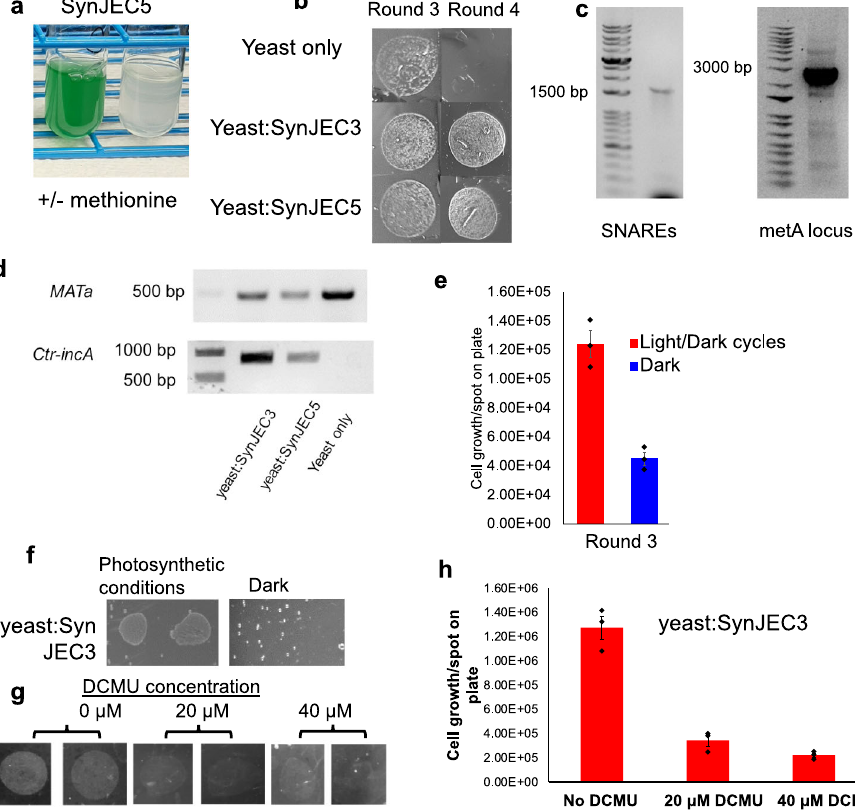
Fig. 5 Rescue of respiration-de fi cient phenotype by yeast- SynJEC chimeras containing auxotrophic SynJEC5 cells. a Growth of SynJEC5 cells in BG-11 medium in the presence and absence of L-methionine b Growth of yeast- SynJEC3 and yeast- SynJEC5 chimeras on Selection Medium III. The experiment was repeated three times independently with similar results. c Total DNA analysis of SynJEC5 DNA reveals the presence of genomic SNARE-like proteins Ctr-incA and CT813 (left) and disruption of the metA gene with a kanamycin resistance marker (right). The experiment was repeated twice independently with similar results. d Total DNA of yeast-SynJEC chimeras contains yeast MATa and SynJEC Ctr-incA genes. The experiment was repeated three times independently with similar results. e S. cerevisiae cox2-60 -SynJEC3 chimeras are generated under and selected under photosynthetic conditions. After two rounds of growth S. cerevisiae cox2-60 -SynJEC3 chimeras are propagated either under standard photosynthetic conditions or under dark; initial number of cells plated per spot is 10 4 ( N = 3 technical replicates; data are presented as mean values + / − SEM). P -values were calculated by two-tailed t -test comparing the two means (95% CI, Cohen ’ s d = 6.2, P = 0.0016). f SynJEC3 are starved for light for 72 h and the fused to S. cerevisiae cox2-60 and selected under dark conditions (dark fusions). The S. cerevisiae cox2-60- SynJEC3 chimeras generated from dark fusions fail to grow whereas the control S. cerevisiae cox2-60- SynJEC3 chimeras propagated under photosynthetic conditions propagate as previously observed. The experiment was repeated twice independently with similar results. g Plate images to demonstrate the effect of (3-(3,4-dichlorophenyl) − 1,1-dimethylurea), DCMU, on S. cerevisiae cox2-60- SynJEC3 chimeras. The experiment was repeated twice independently with similar results. h Cell count analysis to demonstrate the effect of (3-(3,4- dichlorophenyl) − 1,1-dimethylurea), DCMU, on S. cerevisiae cox2-60- SynJEC3 chimeras ( N = 3 technical replicates; data are presented as mean values + / − SEM). P -values were calculated by two-tailed t -test comparing the two means. Source data are provided as a Source Data fi